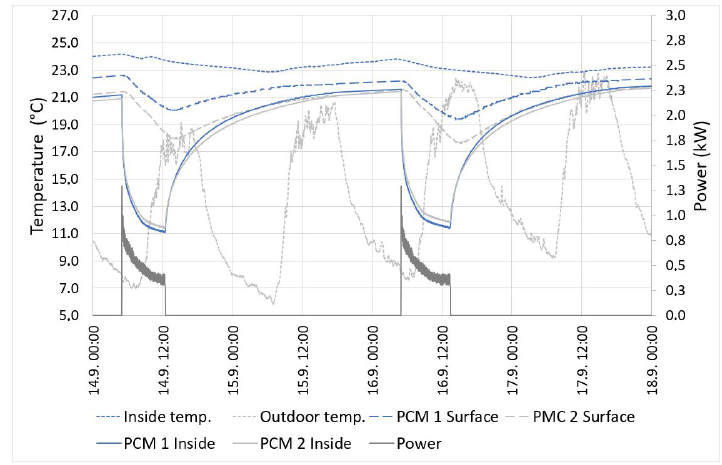
Figure 9. Active cooling—heat